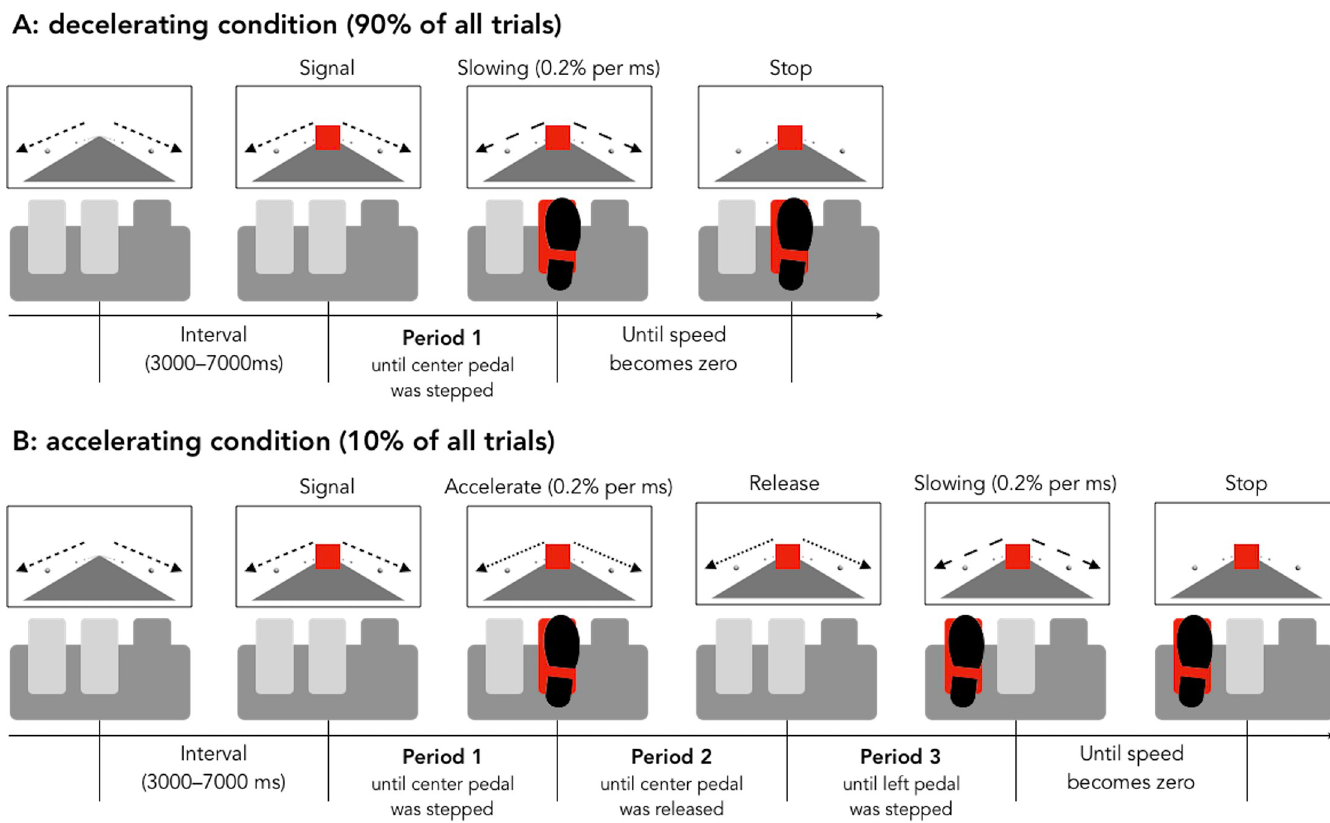
Fig 1. Schematic illustrations of trials for the (A) decelerating condition and (B) accelerating condition during the pedal stepping task. Participants were asked to stop the optic flow if the red signal was presented. During the decelerating condition, the speed of the optic flow decreased if the participant stepped on the center pedal. During the accelerating condition, the optic flow speed increased if the participant stepped on the center pedal; it decreased if the participant stepped on the left pedal. The two arrows on each screen were illustrated for descriptive purposes only and did not appear on the actual screen.